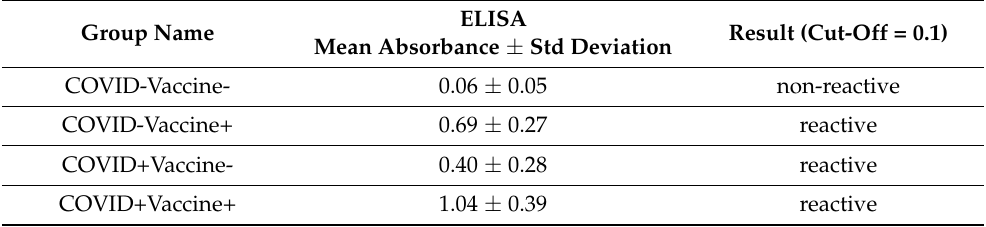
Table 1. Anti-SARS-CoV-2 specific immunoassay among the analyzed patient groups (COVID- Vaccine-, COVID-Vaccine+, COVID+Vaccine-, and